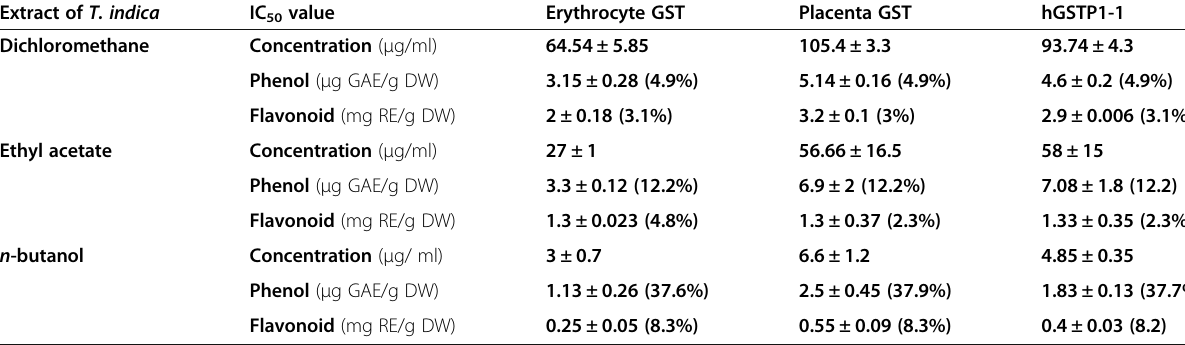
Table 4 IC 50 values and phenol content for the T. indica fractions ability to inhibit the activity of purified GSTs Extract of T.